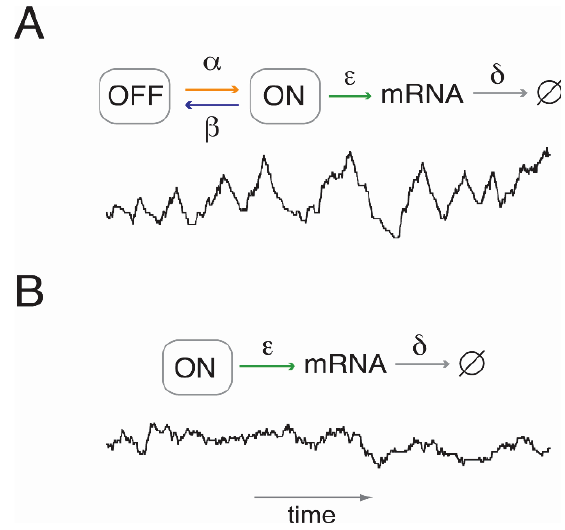
Figure 2. Transcript number fluctuations with and without transcriptional bursting. ( A ) An example or “ sample path ” (black line) for transcription with random transitioning between two promoter states, ON and OFF, that are conducive and inconducive to transcription, respectively. The sample path was calculated using Gillespie’s stochastic simulation algorithm [33]. The level of expression may be controlled by either one of four parameters: burst frequency, α ; burst duration, β −1 ; the initiation rate of transcription in the ON state, ε ; and the rate per molecule of mRNA degradation, δ . ( B ) Sample path in the absence of transcriptional bursting (random birth-and-death process). The transcript level may be controlled by ε and δ